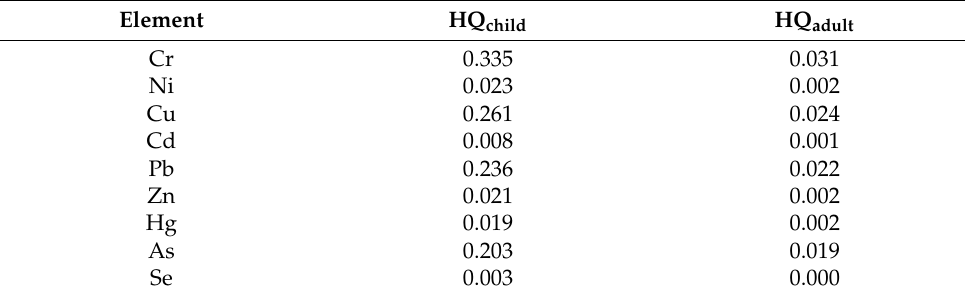
Table 6. Noncarcinogenic exposure risk values for children and their parents.